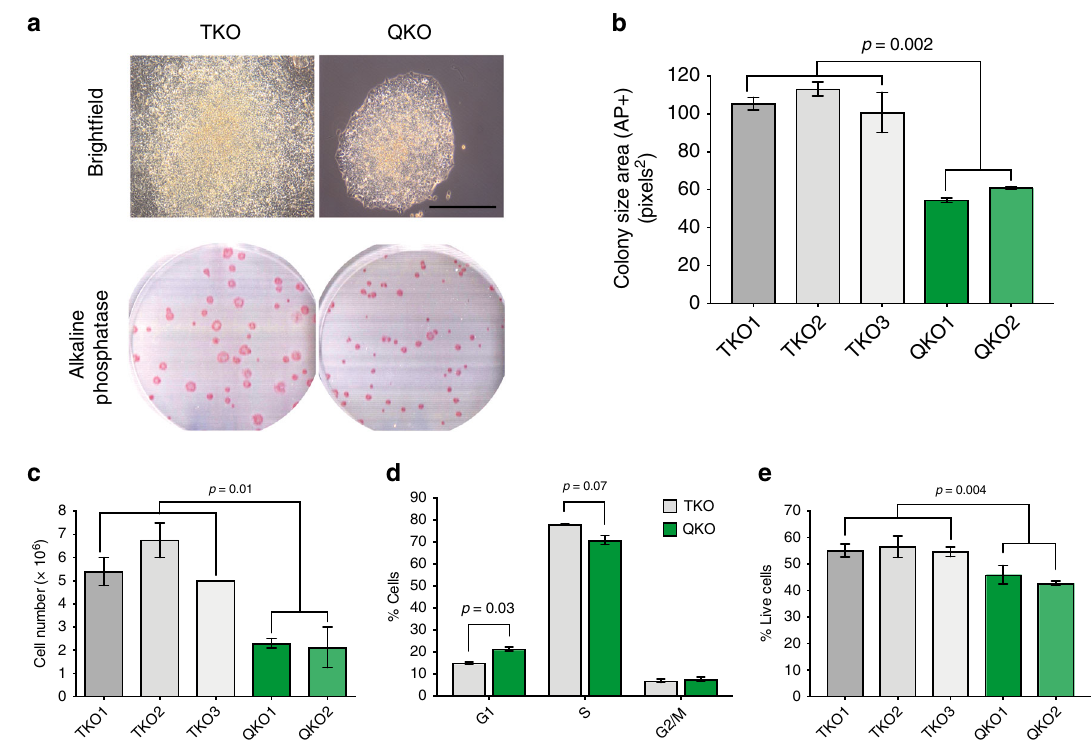
Fig. 5 Loss of E2F4 leads to defects in the growth of RB family TKO mouse ES cells. a Representative bright fi eld images (scale bar, 400 µ m) and alkaline phosphatase (AP) staining (wells from a 6-well plate are shown) of RB family triple knockout (TKO) and RB family knockout, E2F4KO (QKO) colonies one week after plating single cells (n > 10 assays per genotype). b Quanti fi cation of the size of AP + colonies (unpaired t -test; n = 2 biological replicates per clone). c Total number of cells per 10 cm dish one week after plating at low density (unpaired t -test; n = 2 biological replicates per clone). d Quanti fi cation of the percentage of cells in G1, S, and G2/M phases based on BrdU/PI FACS analysis (unpaired t -test; n = 2 – 3 biological replicates with 2 TKO and 2 QKO clones), performed 4 days after low density plating. e Quanti fi cation of the percentage of AnnexinVneg/PIneg cells (live cells) in TKO and QKO populations 4 days after low density plating (unpaired t -test; n = 2 biological replicates per clone). Error bars represent ± s.e.m. Data shown as the mean and standard error of the